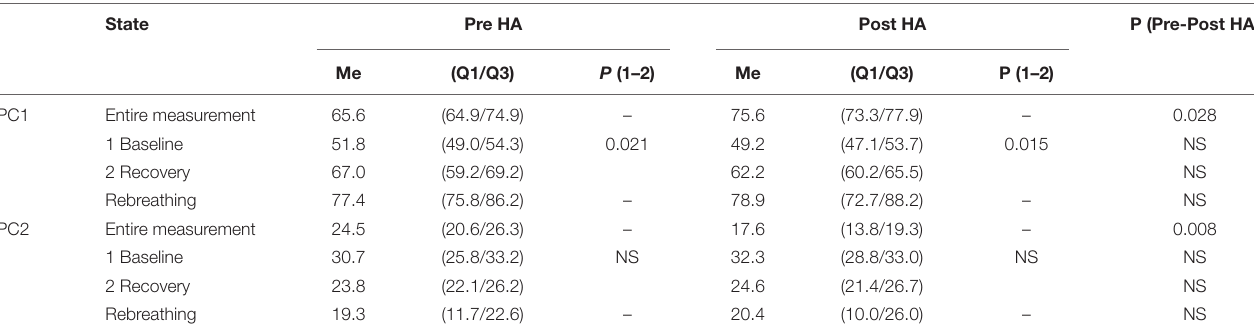
TABLE 2 | Percentage of total variance explained by PC1 and PC2 pre- and post-high altitude. State